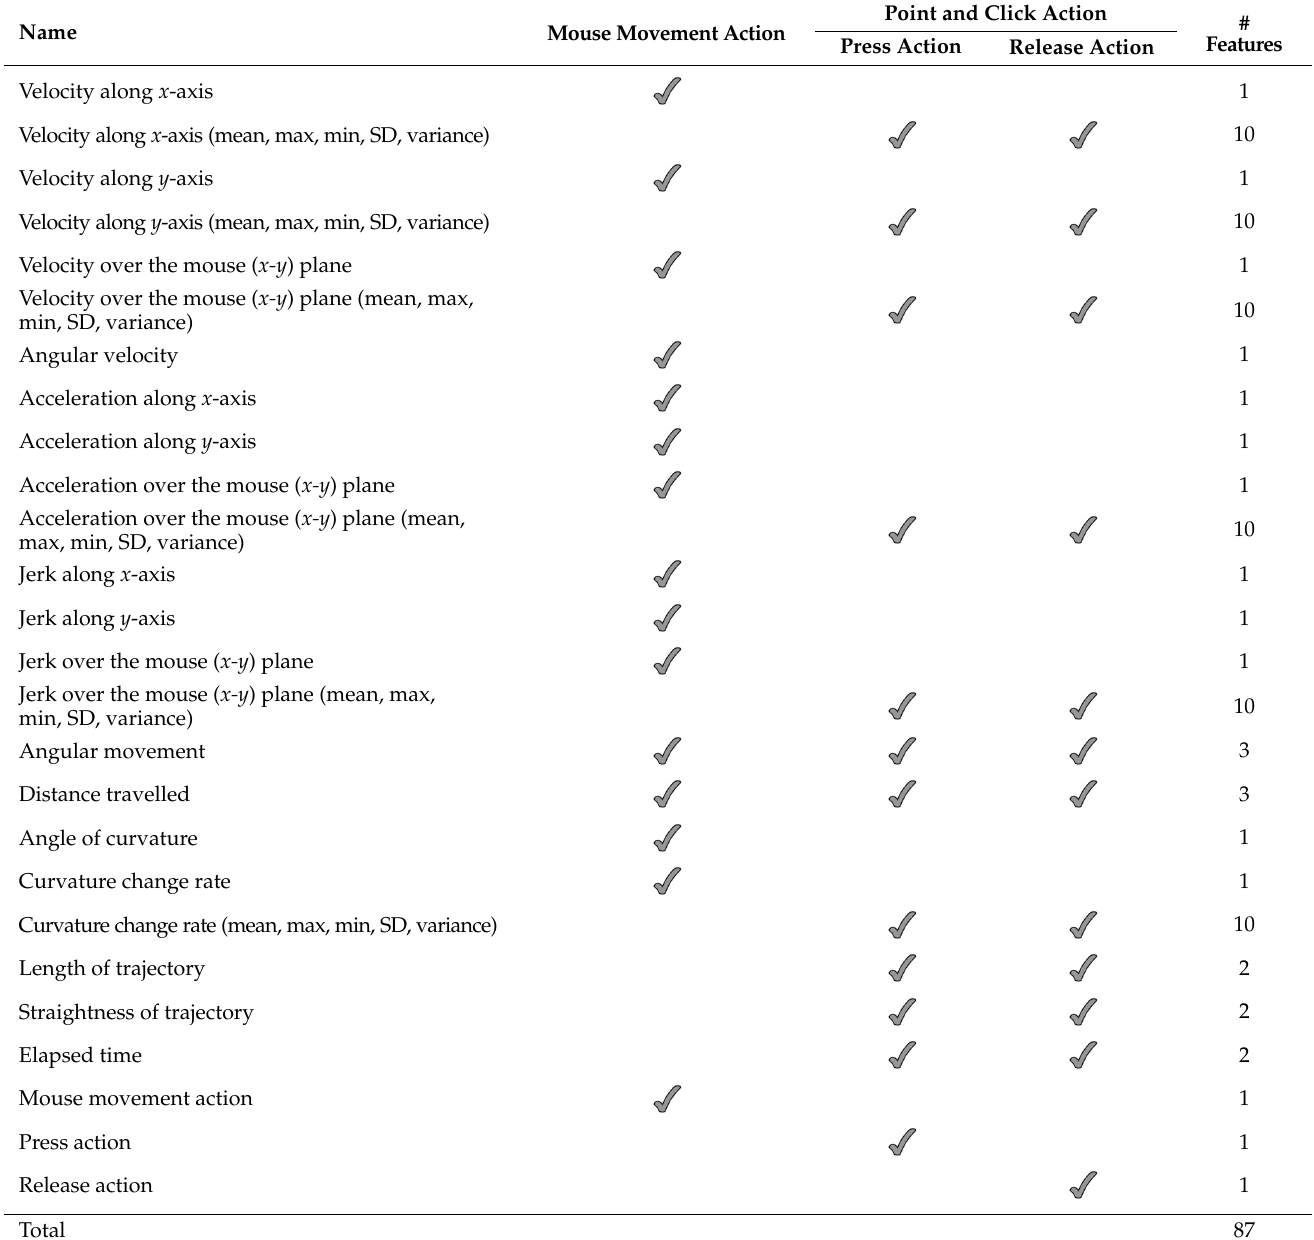
Table 2. Features extracted from mouse movement and point-and-click